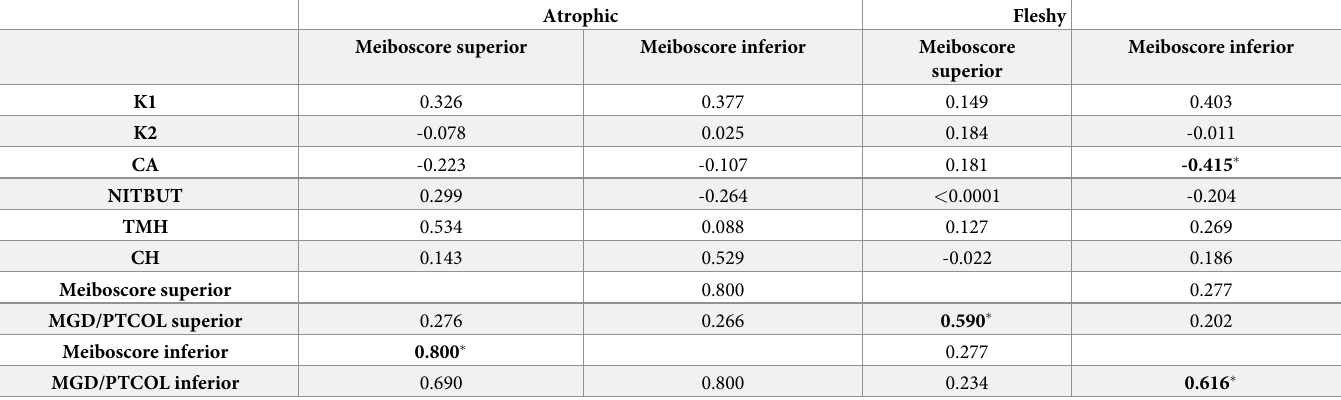
Table 5. Correlations between meibomian gland dysfunction and ocular surface parameters according to pterygium clinical appearance (atrophic and fleshy).